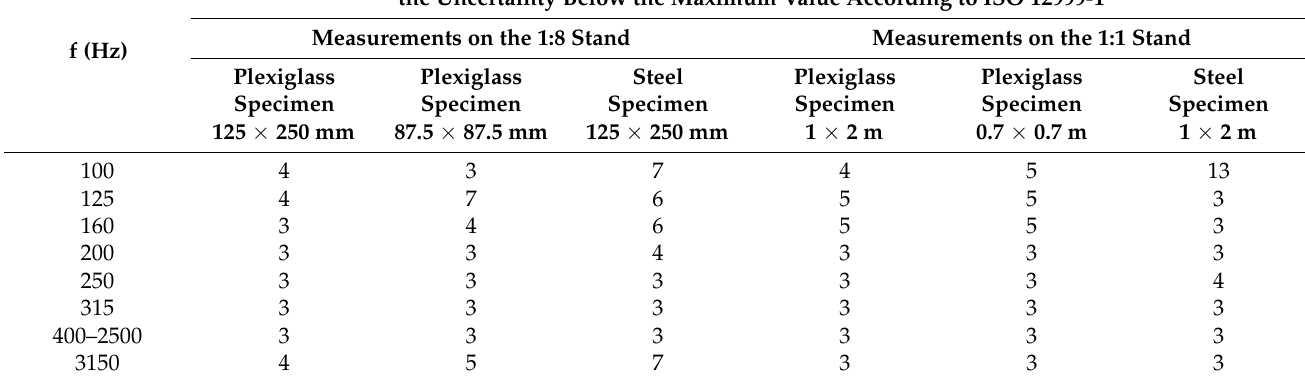
Table 2. Minimum size of measurement sample that ensures keeping the uncertainty below the maximum value according to ISO 12999-1 [26]—values for the full-size stand and the scaled-down stand for all three tested specimens; the results from the scaled rooms were scaled to actual measurement